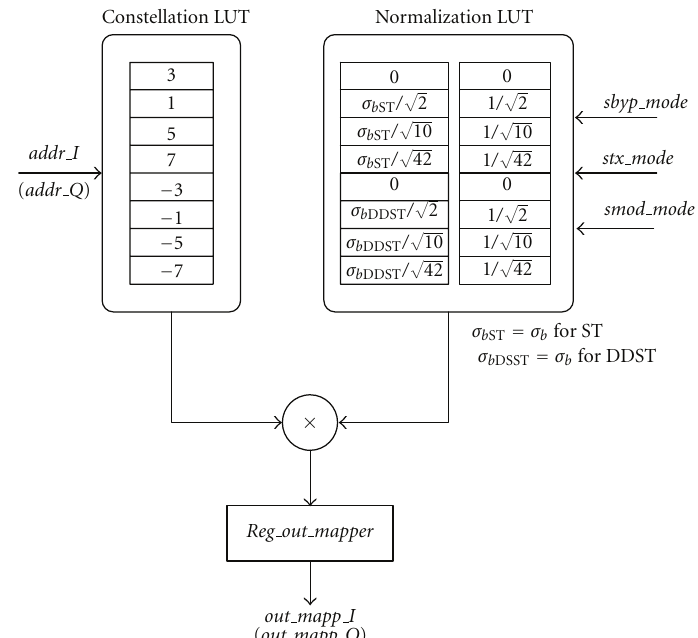
Figure 5: Hardware-e ffi cient 4/16/64-QAM mapper with ST/DDST incorporated.